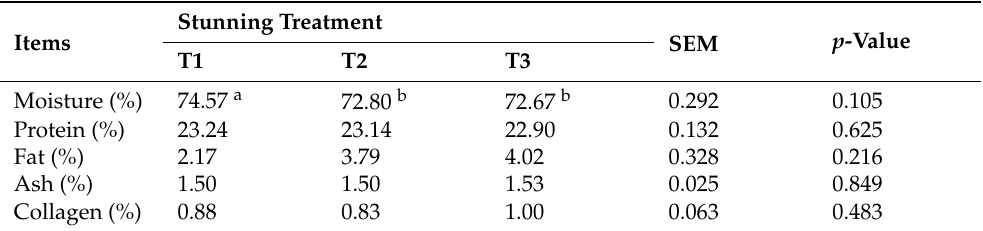
Table 2. Effect of electric and gas stunning (CO 2 -80% and N 2 -98%) on proximate components of pigs meat ( n =